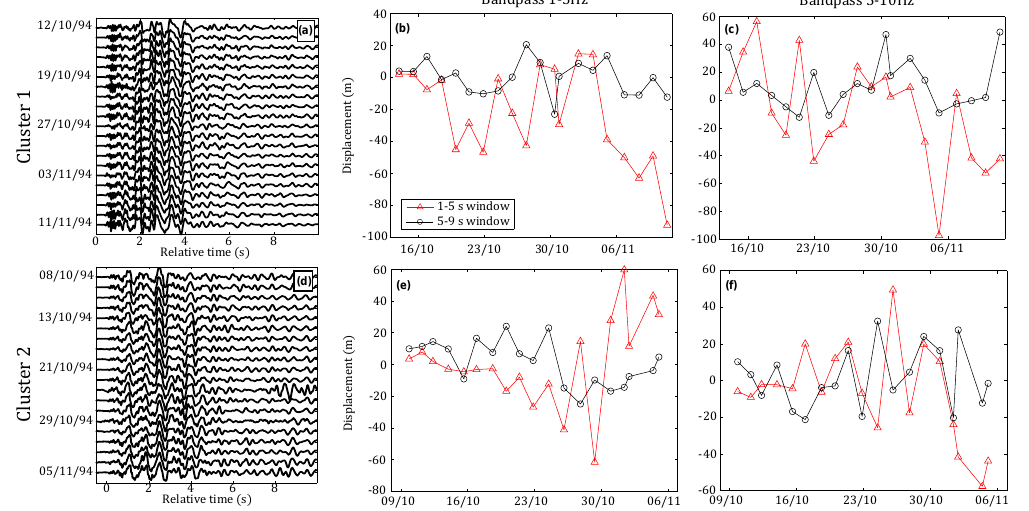
Figure 5. Stacked waveforms (left column) and source displacements between the first stack and all other stacks for data bandpassed between 1–5Hz (middle column) and 5–10Hz (right column). The top and bottom row are for cluster 1 and 2